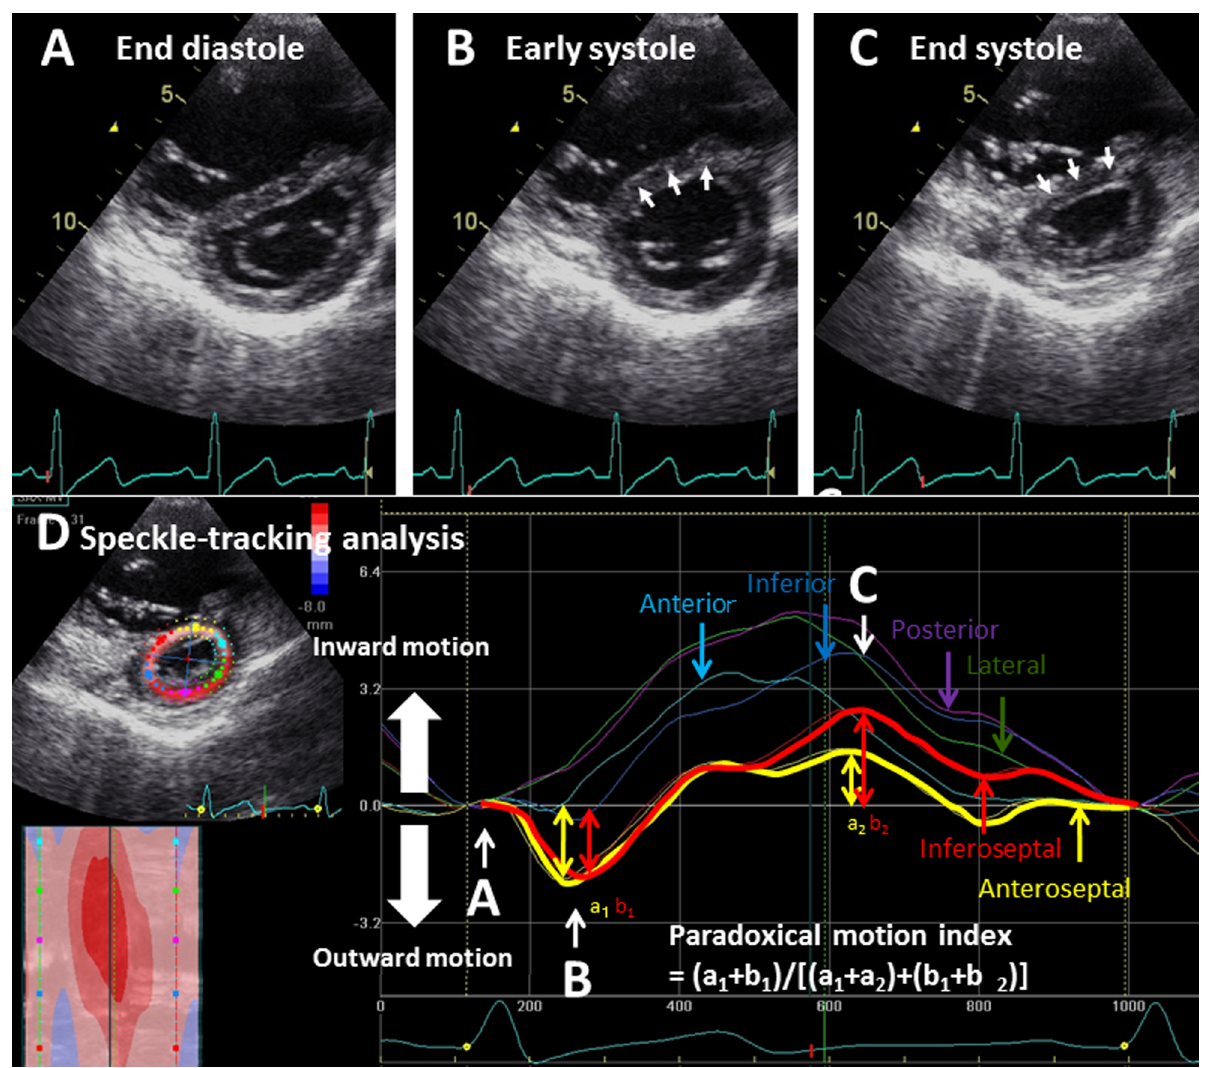
Figure 2. Quantitative assessment of paradoxical motion of the interventricular septum. Panels A, B and C show short axis images of the left ventricle at three cardiac phases of a patient with PH. From the end-diastolic phase (A) to the early systolic phase (B), the interventricular septum moves outward (toward right ventricle) in a paradoxical manner (B, arrows). Subsequently, from early systole (B) to end-systole (C), the interventricular septum moves inward in a manner similar to that of the other segments of the LV wall (panel C, arrows). However, the maximum inward motion was less than that of the other LV wall segments (D). To quantify the paradoxical interventricular septal motion indicated by arrows in panel B, we used speckle-tracking echocardiography by which the left ventricular free walls and interventricular septum were automatically divided into six segments, and each motion pattern was visualized by six lines (D). Yellow and red lines indicate the motion of the anterior and inferior interventricular septum, respectively, during a single cardiac cycle. The dips in the early systolic phase (a1 and b1) indicate their paradoxical motion. For quantitative assessment, the maximum depths of the yellow and red lines (a1 + b1) were added. Next, the entire distance of the two interventricular septal segments [early systole (a1 and b1) and end-systole (a2 and b2)] were added. Then, (a1 + b1) was divided by (a1 + a2 + b1 + b2), and the result was used as the paradoxical motion index of the interventricular septum.